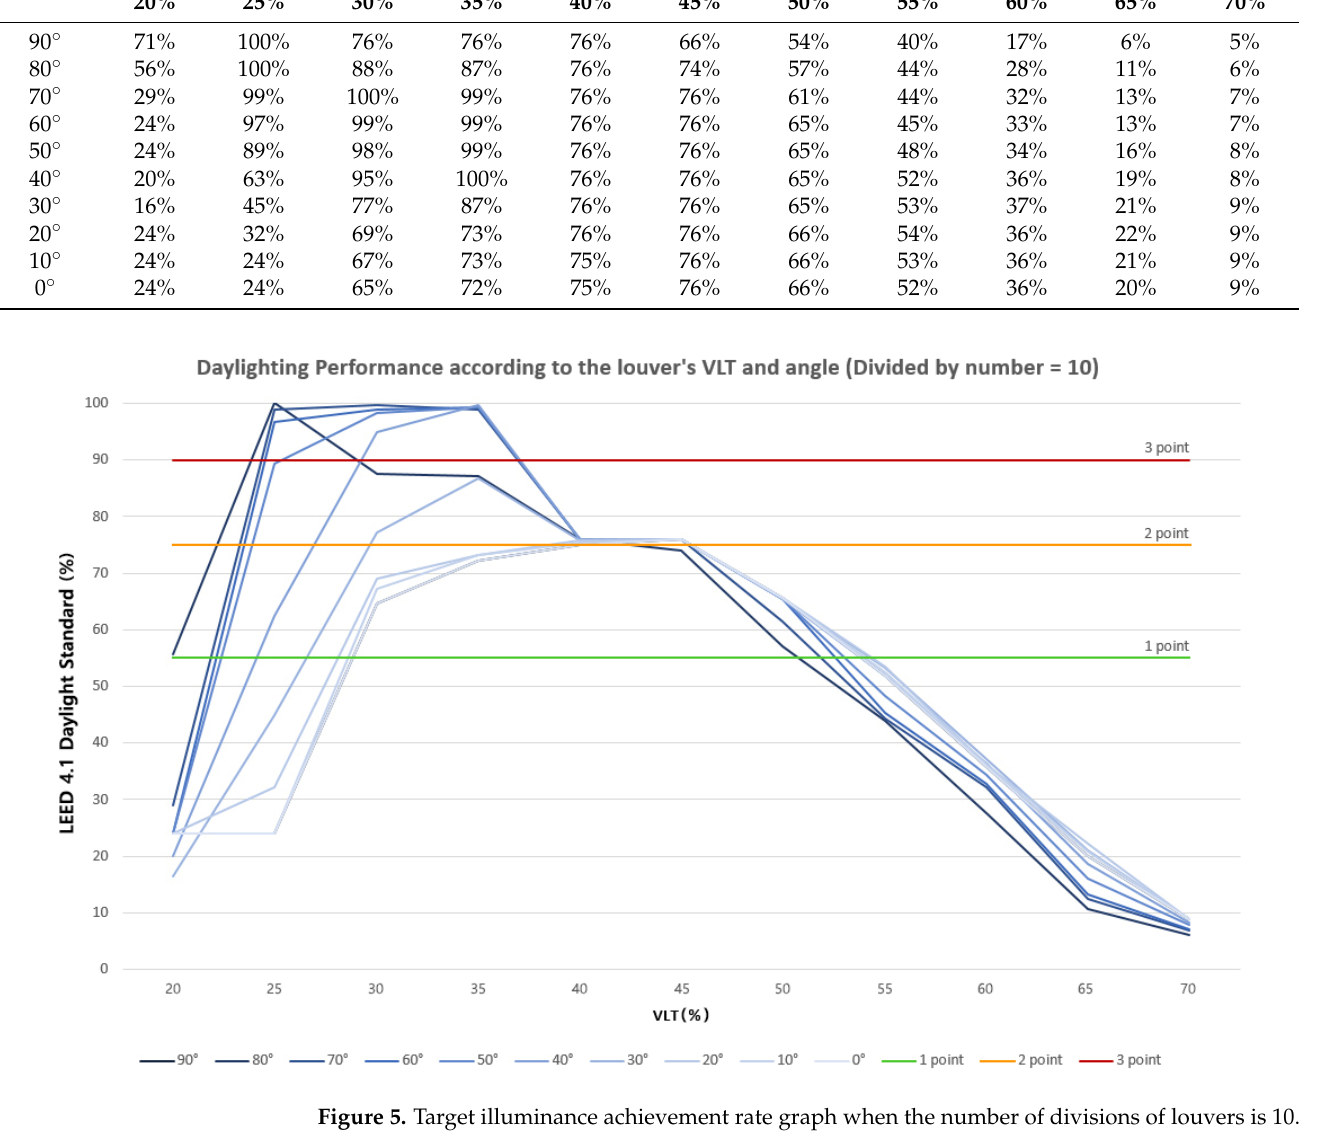
Table 4. Target illuminance achievement rates when the number of divisions of louvers is 10. Angle